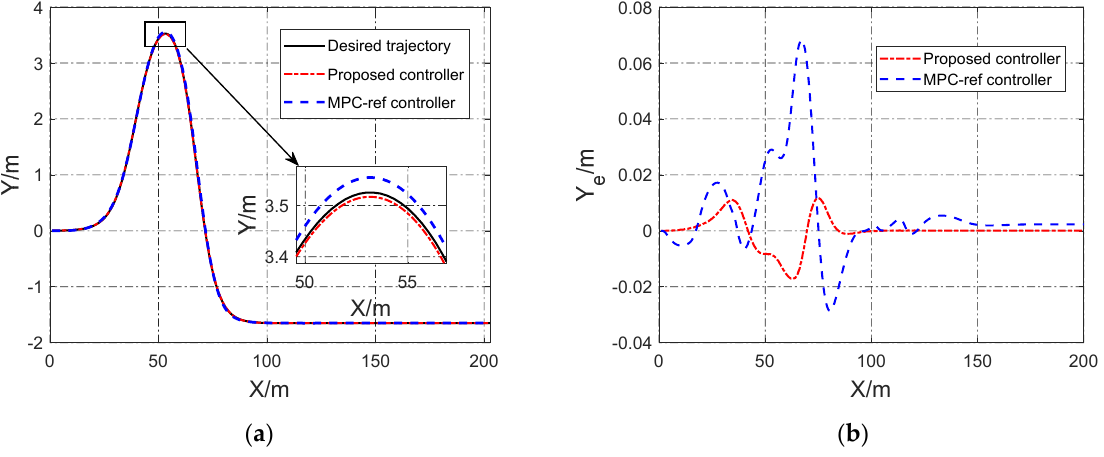
Figure 13. Trajectory tracking results compared to the algorithm proposed at 36 km · h − 1 ; ( a ) Comparison of driving paths; ( b ) Comparison of lateral errors.